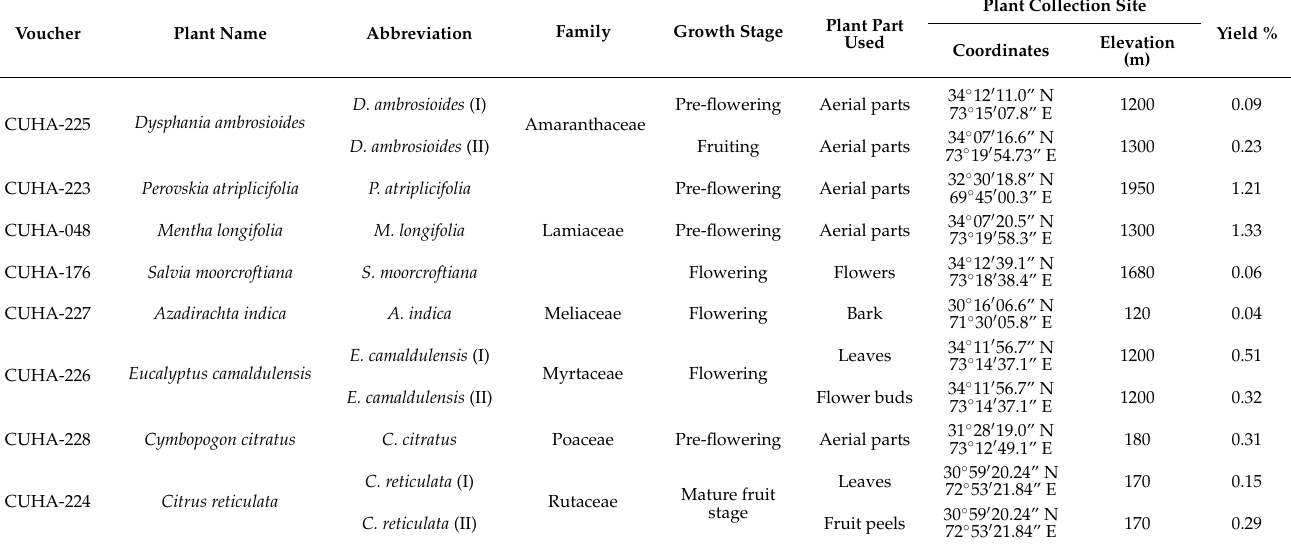
Table 1. Description of plants used and percent yield of the essential oils extracted by steam distilla- tion